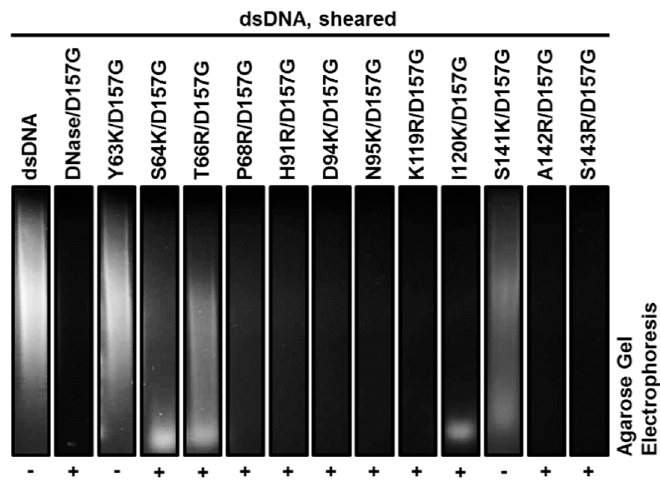
Figure 3. Digestion of sheared dsDNA by nuclease mutants. Sheared dsDNA (UltraPure TM Salmon Sperm DNA Solution) exhibited an average size of ≤ 2000 bps. Negative control containing substrate without enzymes is indicated as “dsDNA”. The positive control DNase / D157G and mutants S64K / D157G, H91R / D157G, D94K / D157G, N95K / D157G, K119R / D157G, I120K / D157G, A142R / D157G, and S143R / D157G were able to completely hydrolyze sheared dsDNA. S64K / D157G, T66R / D157G, and I120K / D157G partially degraded sheared dsDNA within 1 h at 25 ◦ C. Y63K / D157G and S141K / D157G did not exhibit activity towards sheared dsDNA. Note: “ + ” indicates activity and “ − ” indicates inactivity, without any quantification of the activity